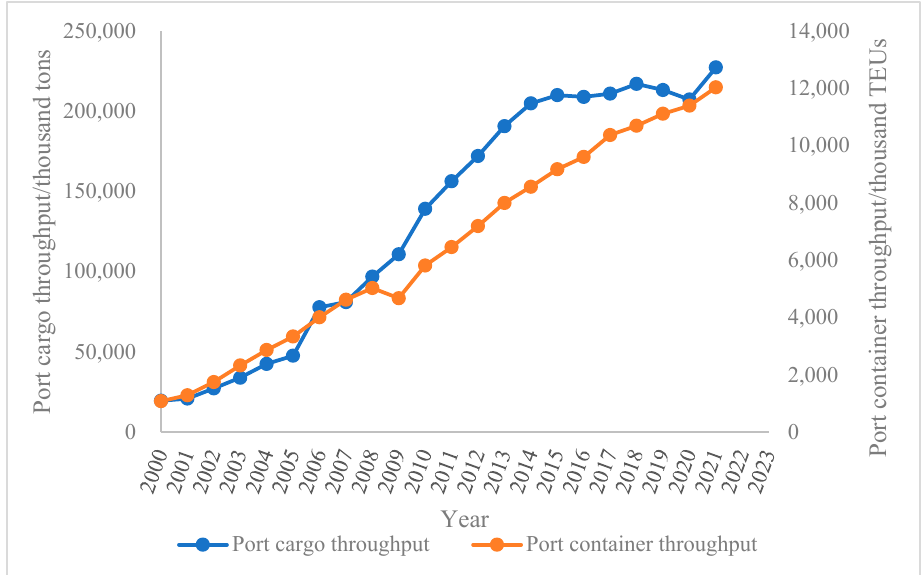
Figure 2. Cargo throughput and container throughput for Xiamen Port from 2000 to 2021.